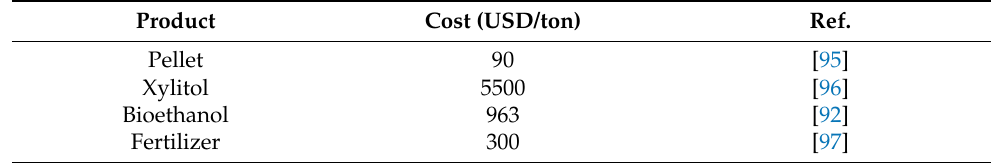
Table 7. Selling price of products. Product Cost (USD/ton)